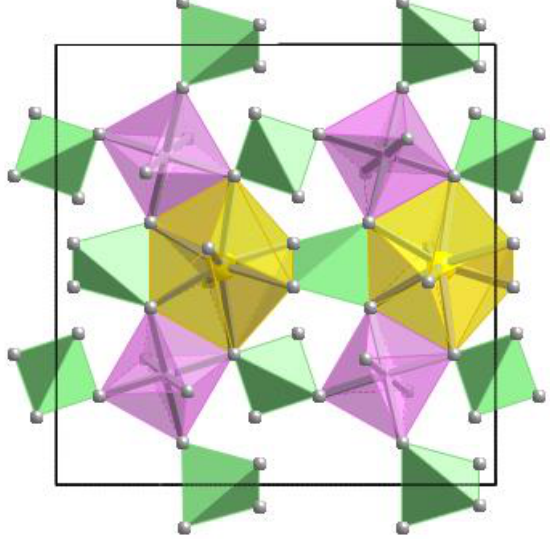
Figure 1. Part of the garnet structure viewed down the c axis, showing the linkages of the various polyhedra (X = yellow dodecahedra, Y = pink octahedra, Z = green tetrahedra, and grey spheres = O atoms).